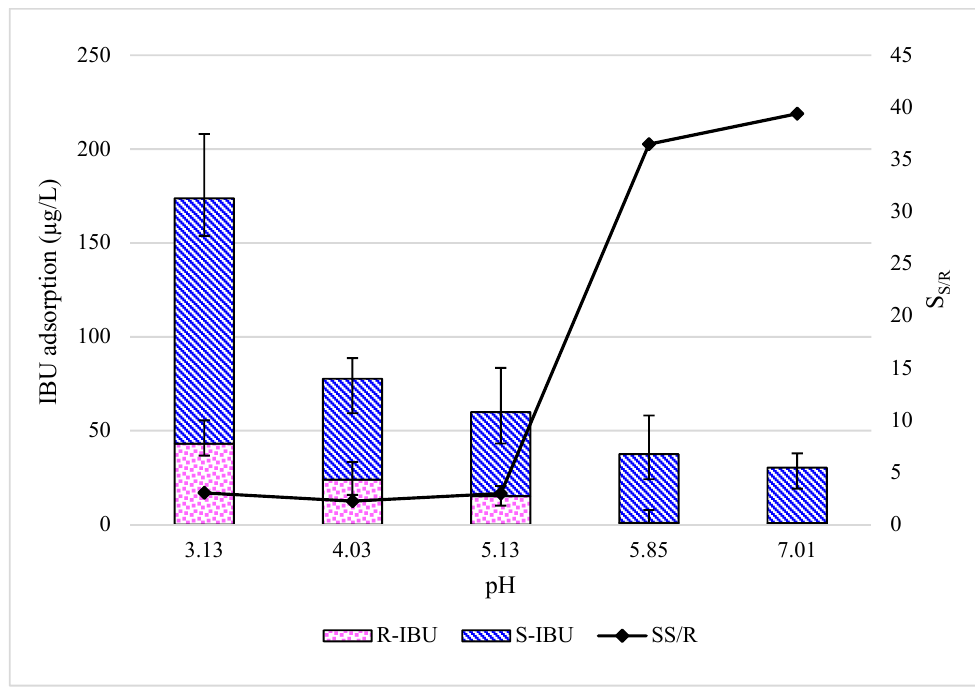
Figure 1. R- and S-enantiomers of ibuprofen (R-IBU and S-IBU) adsorption onto flat-sheet equipment as a function of feed water pH (temperature 20 ± 1 °C). Selectivity is a ratio of adsorption of S/R IBU.